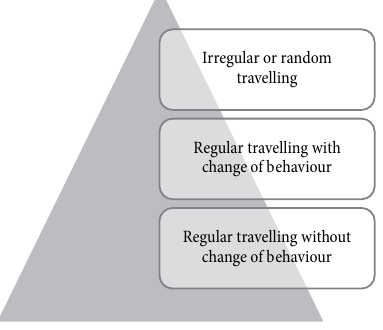
Fig. 1. Groups of passengers in